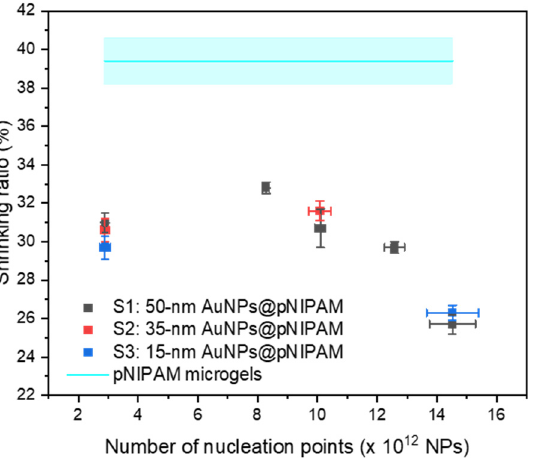
Figure 3. Modulation of the shrinking ratio as a function of the number of nucleation Figure 3 . Modulation of the shrinking ratio as a function of the number of nucleation points.